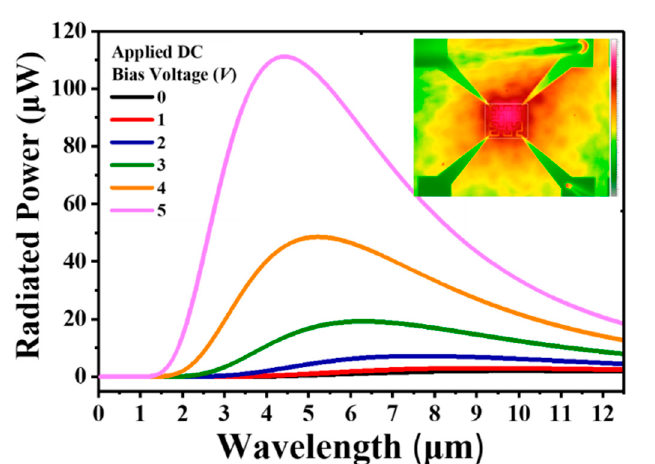
Figure 4. Blackbody radiated power of a Peano-shaped microheater under different applied DC bias voltage. Inset is IR thermal radiation measured with a thermal radiometer.